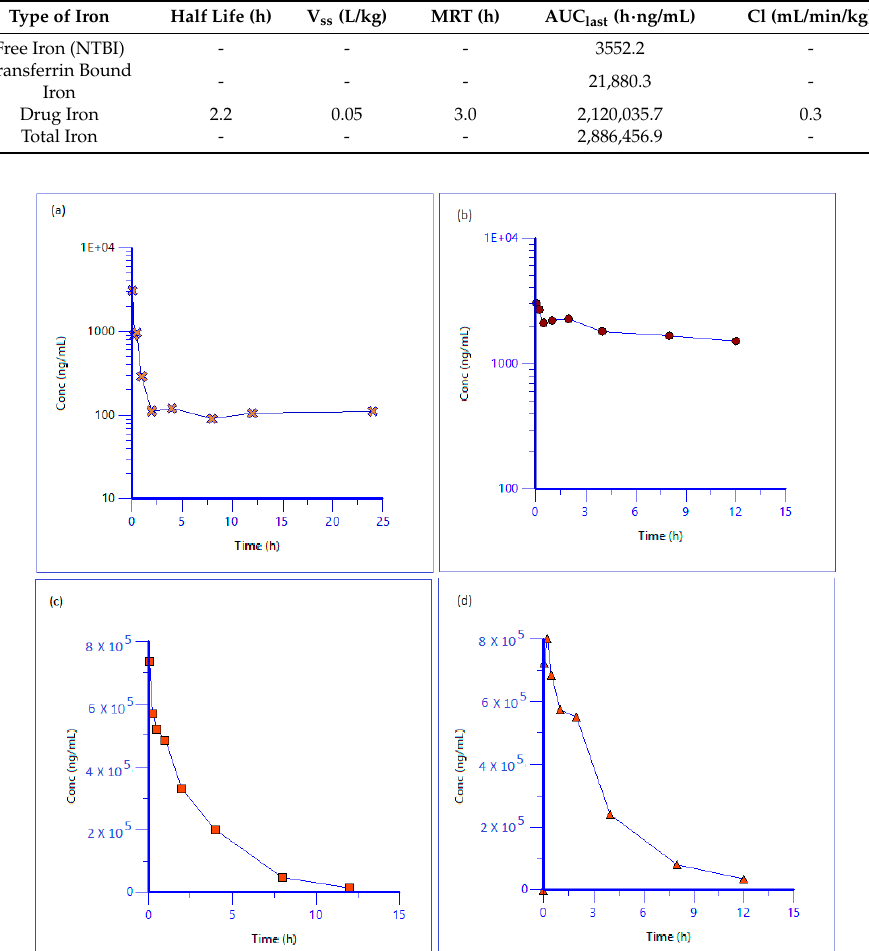
Figure 5. Concentration–time profile of different species of iron ( a ) Free iron (NTBI); ( b ) Transferrin bound iron (TBI); ( c ) Drug bound Iron (DI); ( d ) Total Iron (TI) upon iv bolus (40 mg/kg) administration of colloidal iron formulation in male Sprague Dawley Rats.